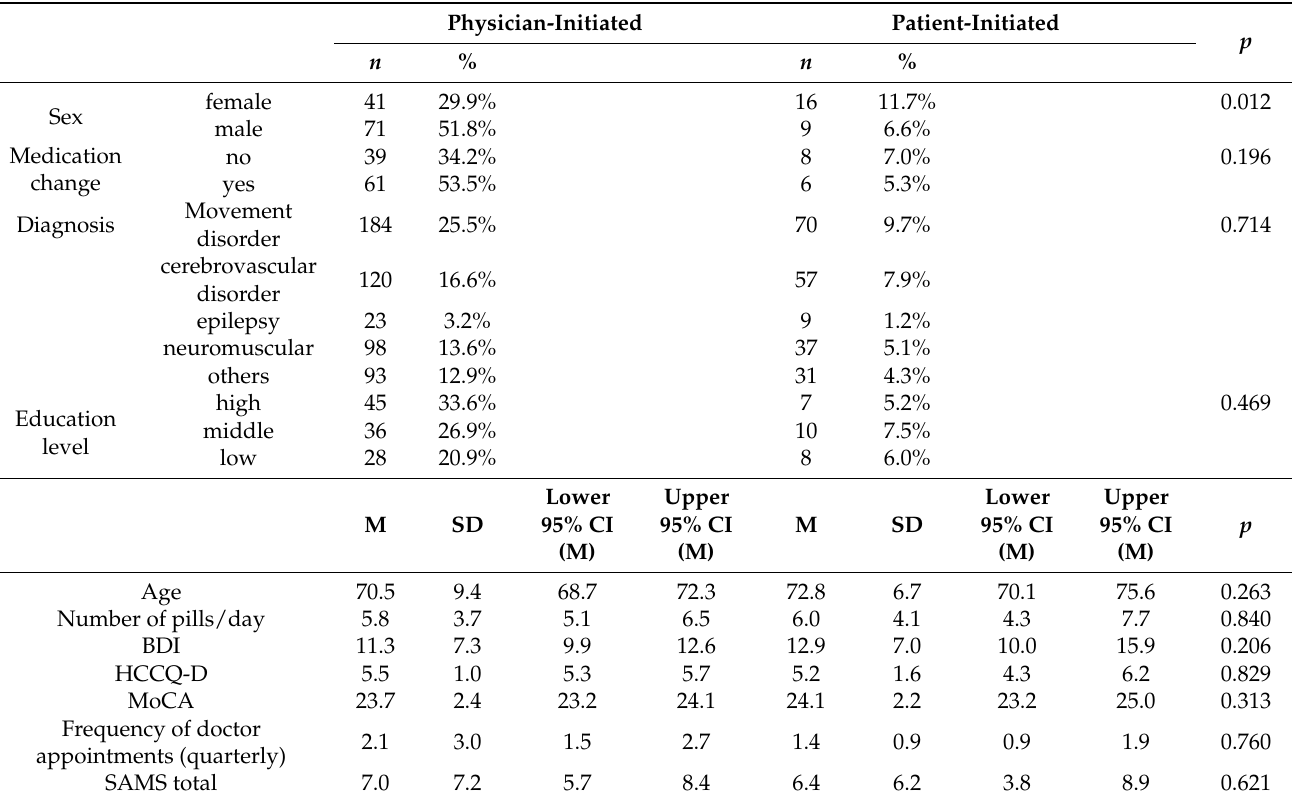
Table 3. Group comparison: cross table for initiator of medication change after discharge.